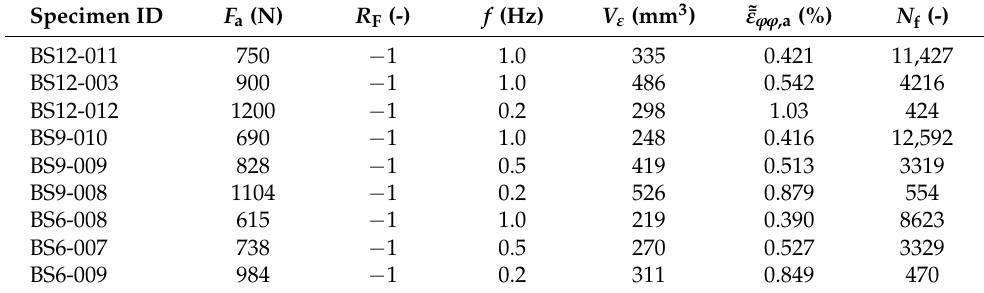
Table 2. Parameters of the LCF tests: Applied force amplitude F a , force ratio R F , the test frequency f , the highly strained volume V ε , the mean effective strain amplitude ˜¯ ε ϕϕ ,a and the numbers of cycles to failure N f of the force-controlled cyclic